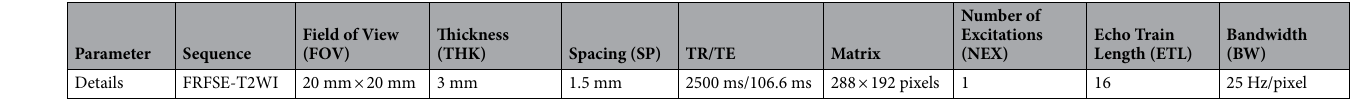
Table 2. Details of MRI scanning